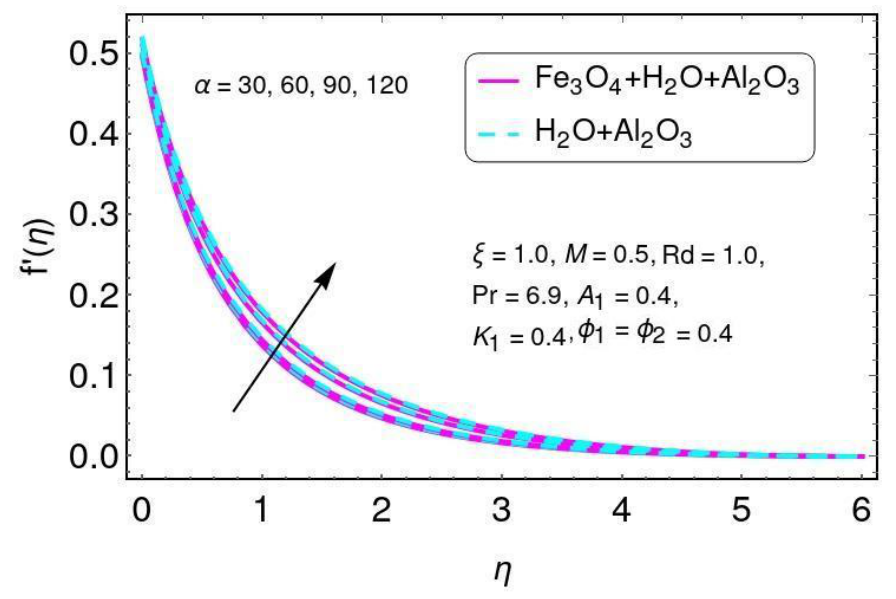
Figure 11. The distribution of f (cid:48) ( η ) for α